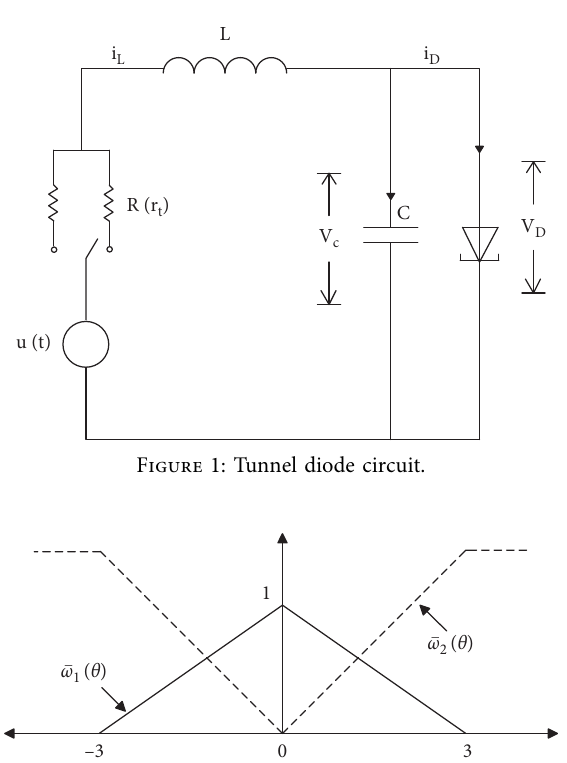
Figure 2: Membership functions.